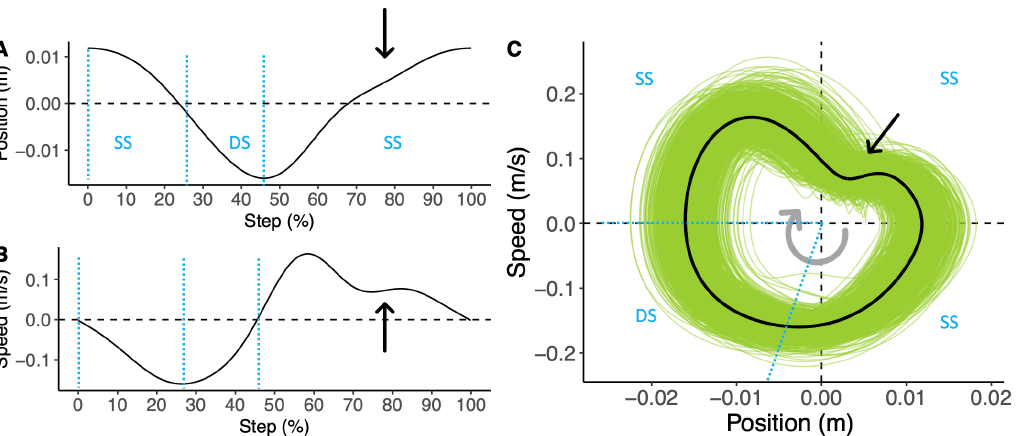
Figure 1. ( A ) Attractor of the centred vertical position of the body’s centre-of-mass (COM) versus time, expressed in % of step time. ( B ) Attractor of the vertical speed of the COM versus time, expressed in % of step time. ( C ) Typical plot of COM vertical trajectory in phase space (solid green lines representing 508 gait cycles) during walking for a participant and of the corresponding attractor (solid black line). The straight arrows outline the deviation from genuine harmonic oscillator. The curved arrow is the arrow of time. Note that a closed loop corresponds to one step cycle, a complete gait cycle being composed of two step cycles. The blue dotted line separate the single stance (SS) and dual stance (DS)